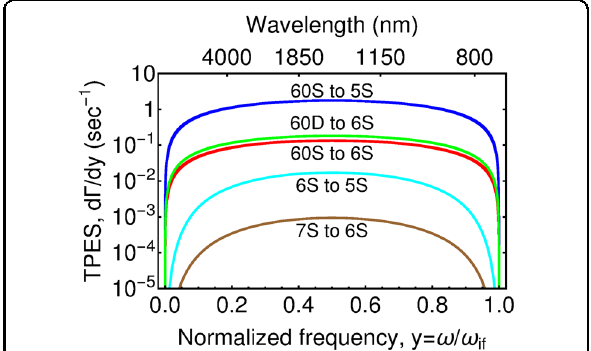
Fig. 2 Comparison between the two-photon emission (TPE) spectra of Rb-87: emission from Rydberg states and from lower energy states. The TPE rates are higher for Rydberg state than for lower energy states by 2 orders of magnitude. The horizontal axis represents the dimensionless frequency y which is normalized by the frequency difference between the initial and fi nal state ω if . The vertical axis is the rate of TPE per unit normalized frequency.